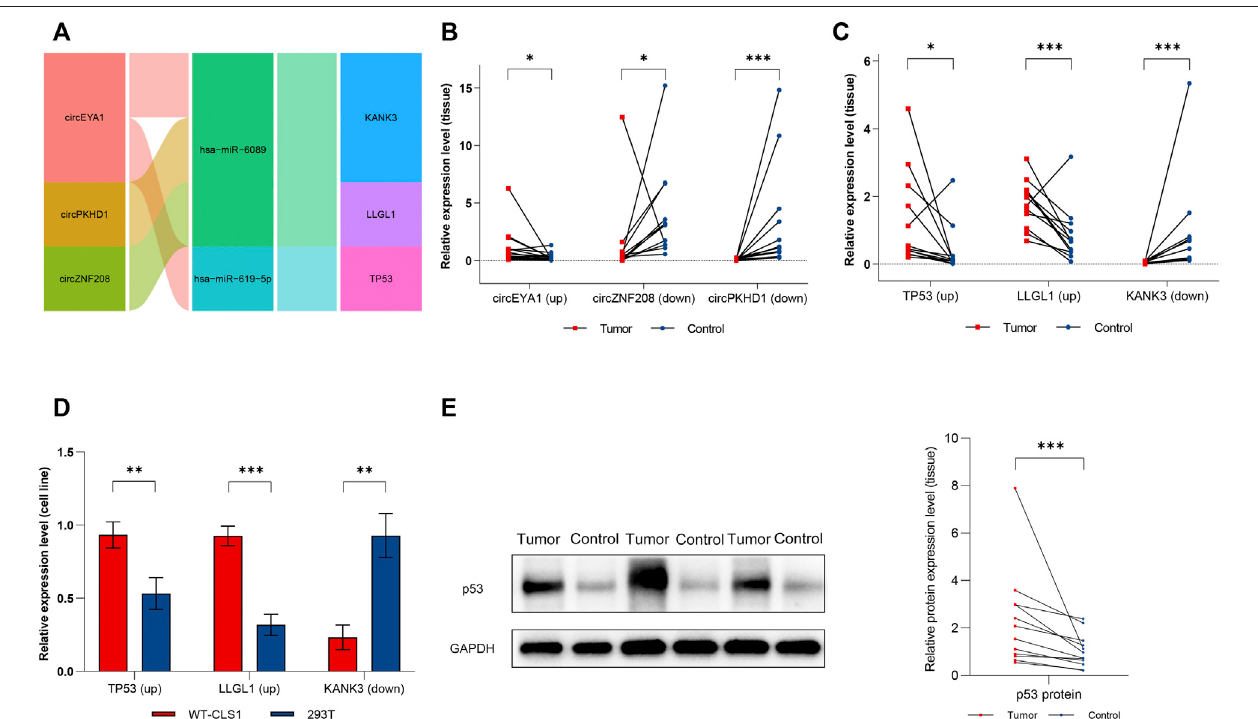
FIGURE10| Veri fi cationofdysregulatedcircRNAsandmRNAs. (A) SankeydiagramoftheceRNAsub-networkforexperimentalveri fi cation. (B) Expressionlevelof circEYA1, circZNF208, and circPKHD1 in clinical samples. (C) Expression level of TP53, KANK3, and LLGL1 in clinical samples. (D) Expression level of TP53, KANK3, and LLGL1 in cell lines. (E) Expression level of P53 protein in clinical samples. Red dots represent tumor samples, blue dots represent normal samples. Results were analyzed by paired t -test (B,C,E) or t -test (D) . *: p < 0.05, **: p < 0.01, ***: p <